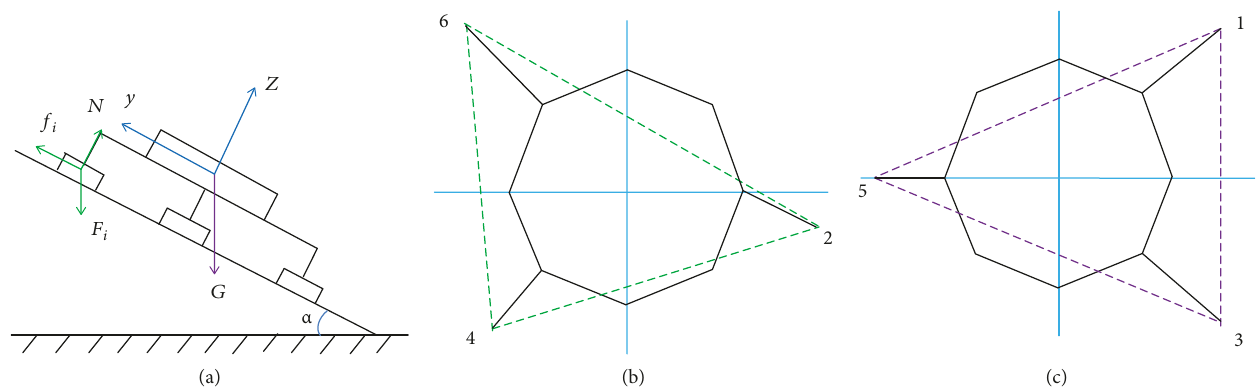
Figure 9: (a) Force analysis of the robot. (b) b status support of the robot. (c) e status support of the robot.